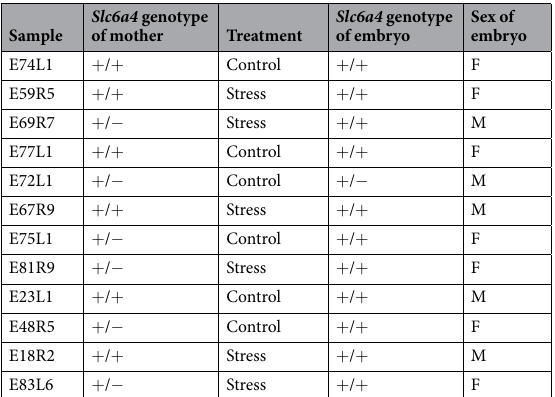
Table 1. Sample summary of embryo brain tissue. I. Sample identifier: E74L1 refers to the first embryo in the left uterine horn (L1) obtained from dam 74 (E74) II. E72L1: removed from study because embryo was heterozygous for Slc6a4 . III. E23L1: was removed from methylome analysis because library was not enriched for methylated